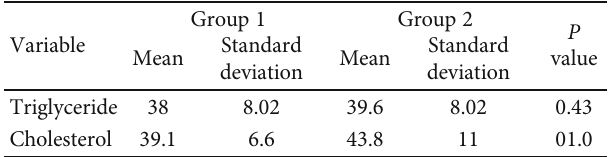
Table 1: Serum cholesterol and triglyceride